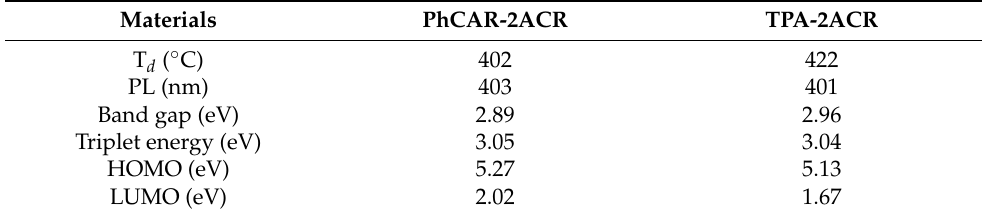
Figure 3. Room temperature and low temperature (100 ms) photoluminescence (PL) spectra of PhCAR-2ACR and TPA-2ACR. Table 1. Thermal, photophysical and electrochemical properties of PhCAR-2ACR and TPA-2ACR.